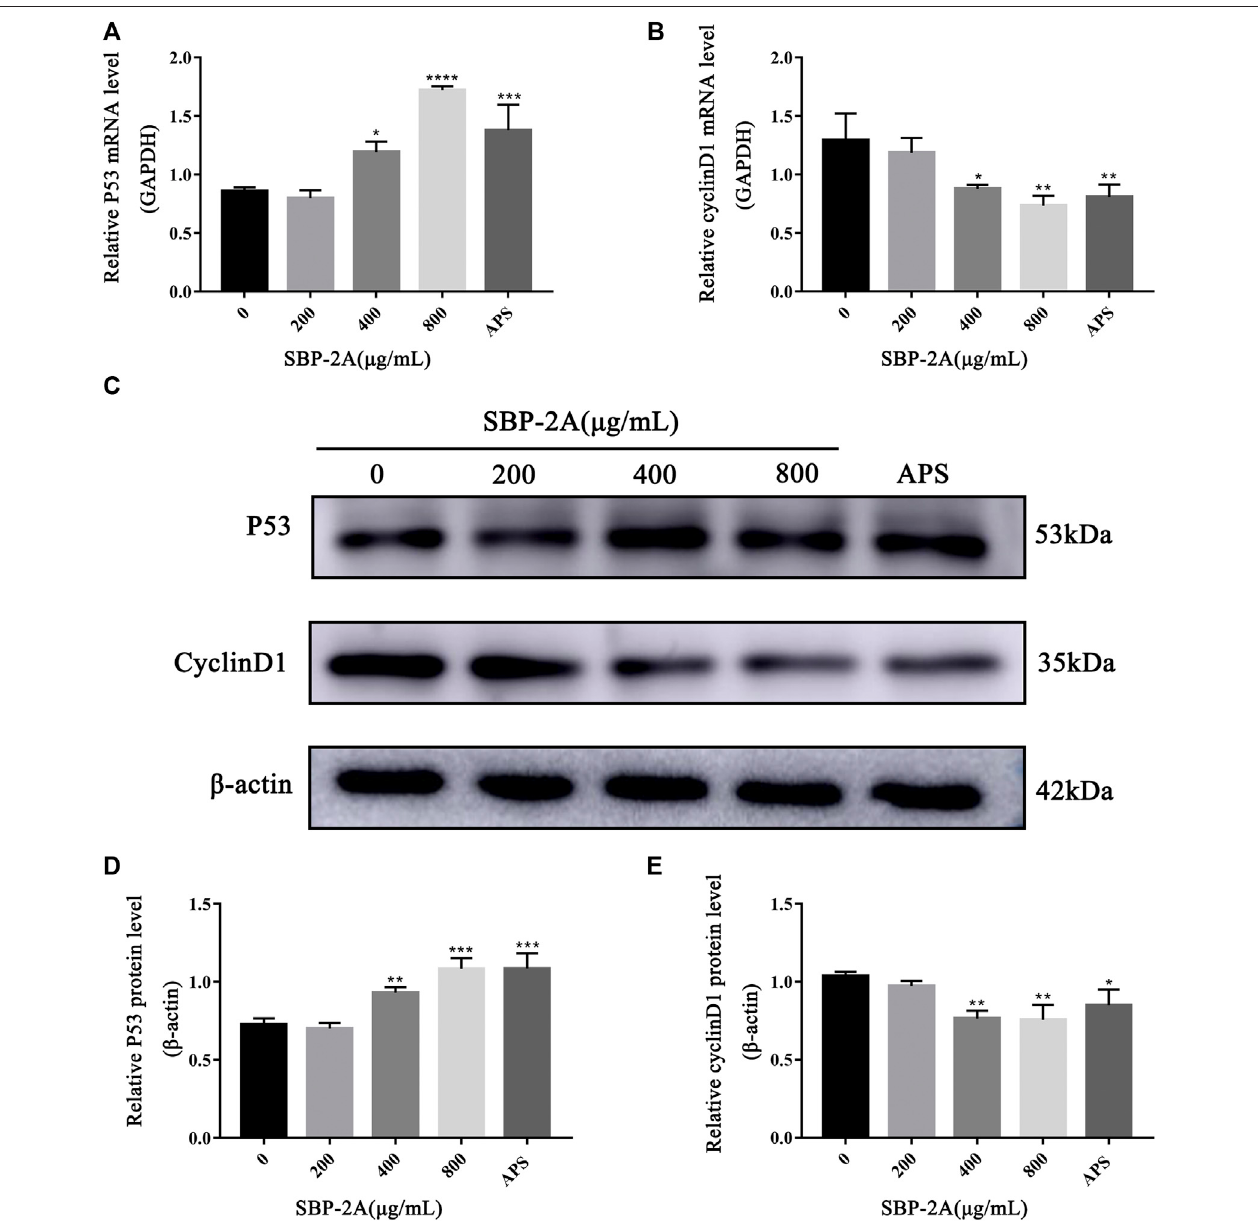
FIGURE 8 | The effect of SBP-2A on the mRNA expression of P53 and CyclinD1 was determined by qRT – PCR (A,B) . Compared to the non-SBP-2A-treated group, * p < 0.05, ** p < 0.01, *** p < 0.001, **** p < 0.0001. The protein expression of p53 and cyclin D1 (C – E) . Compared to the non-SBP-2A-treated group, * p < 0.05, ** p < 0.01, and *** p <